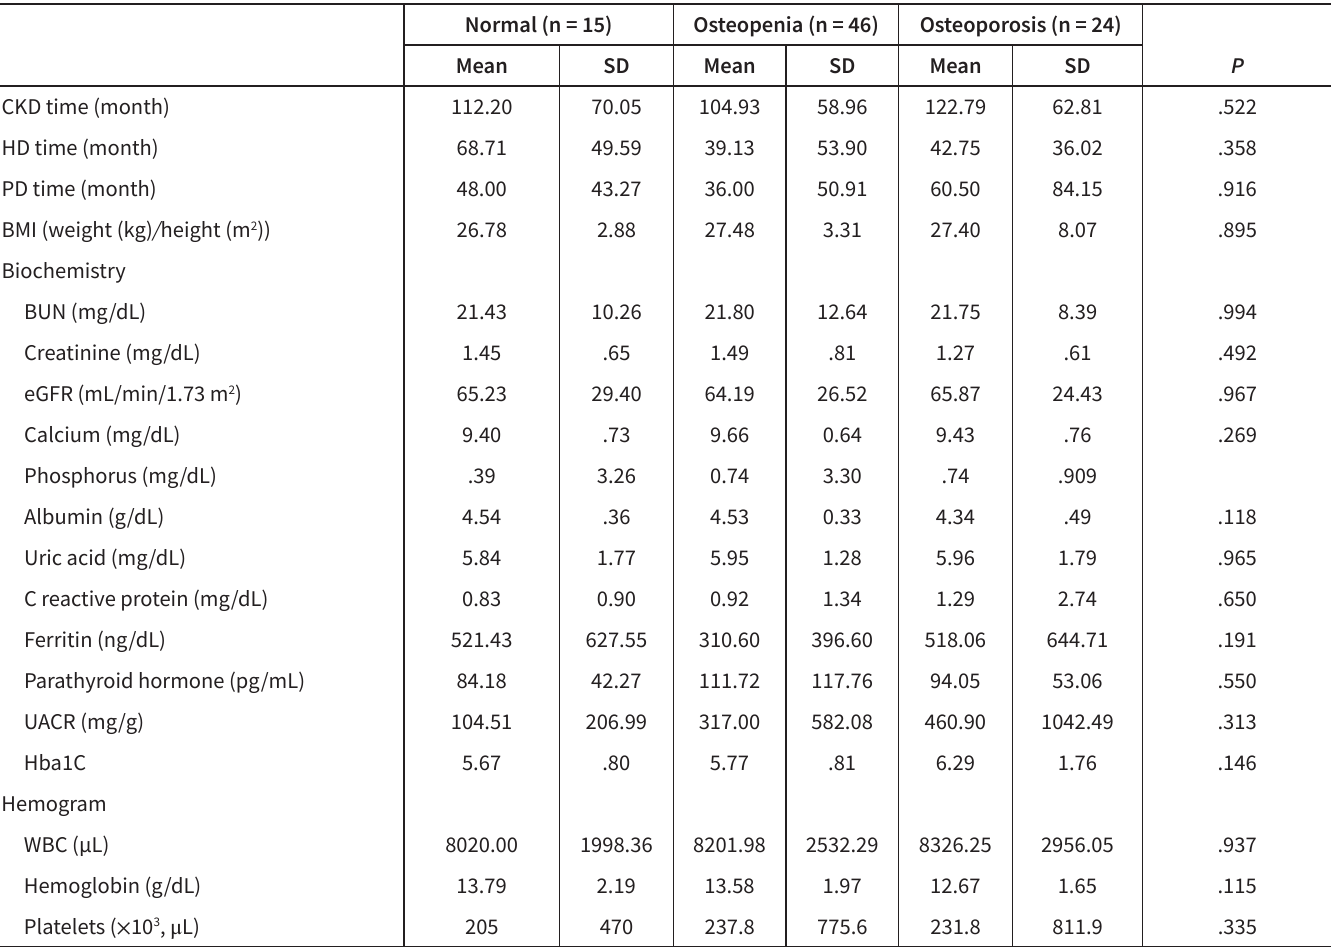
Table 4. Descriptive Statistical Values and Comparison Results of Study Variables by